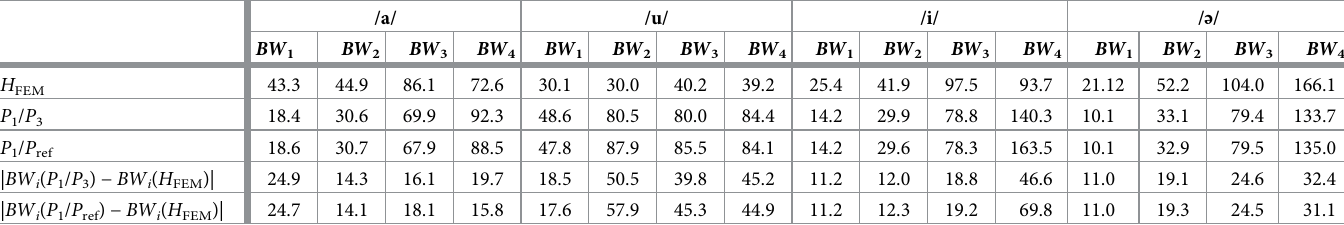
Table 2. Bandwidths in Hz of the simulated and measured transfer functions and their absolute deviations in Hz.